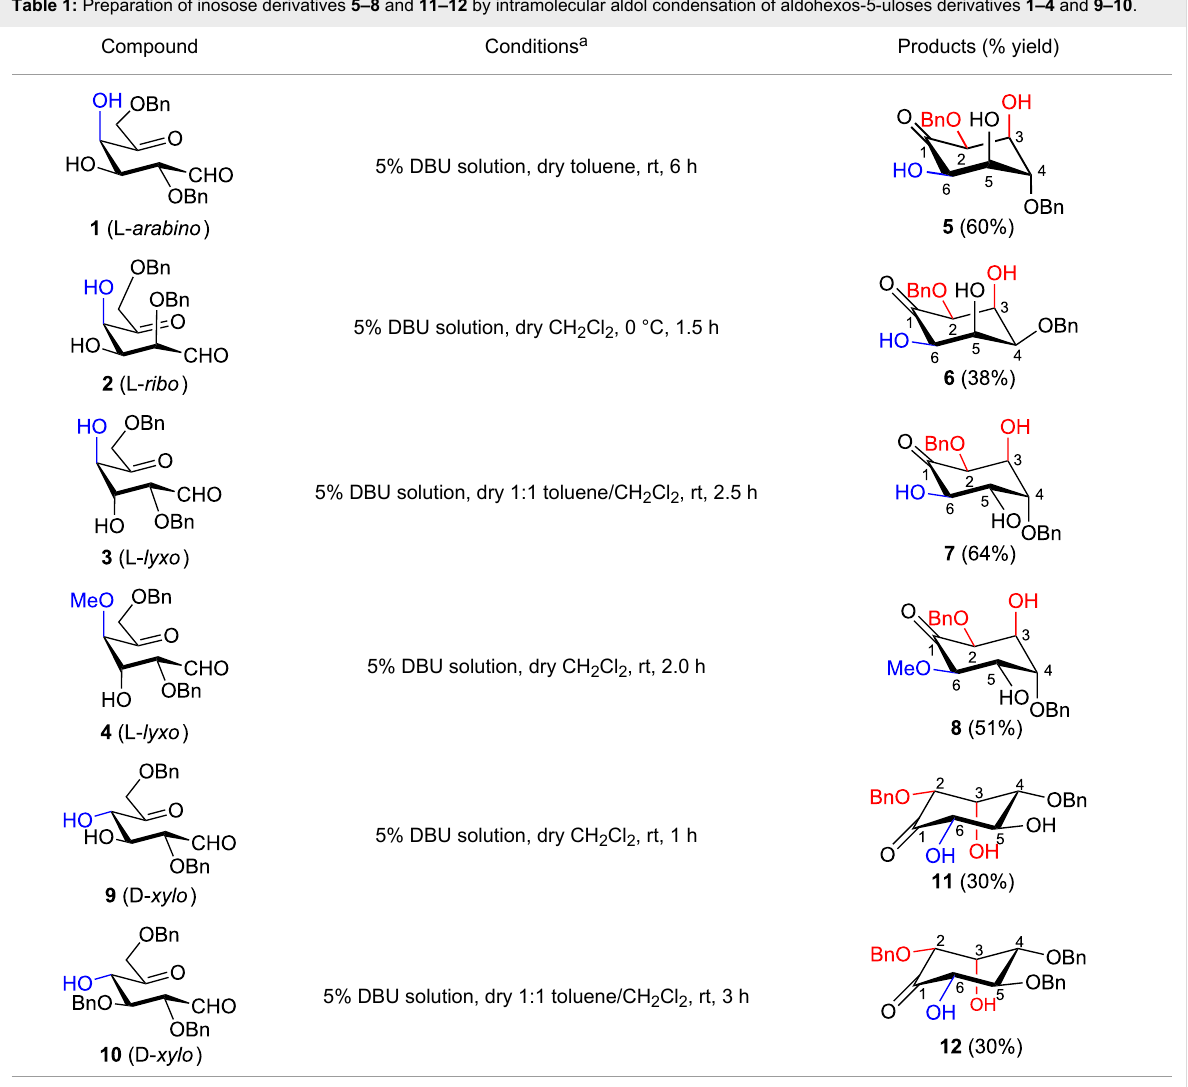
Table 1: Preparation of inosose derivatives 5–8 and 11–12 by intramolecular aldol condensation of aldohexos-5-uloses derivatives 1–4 and 9–10